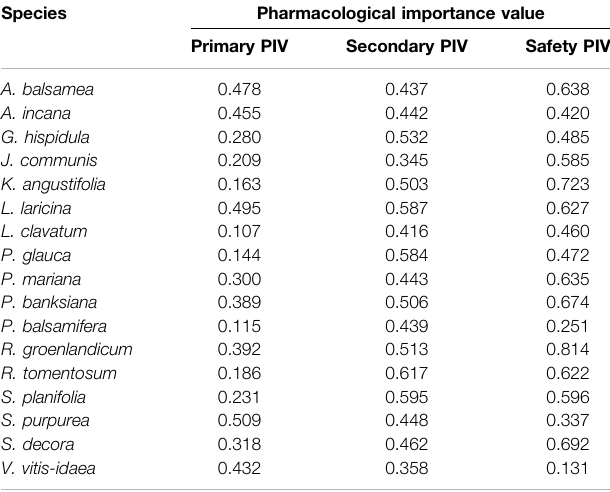
TABLE 2 | Pharmacological importance value (PIV) of 17 CEI medicinal plants.